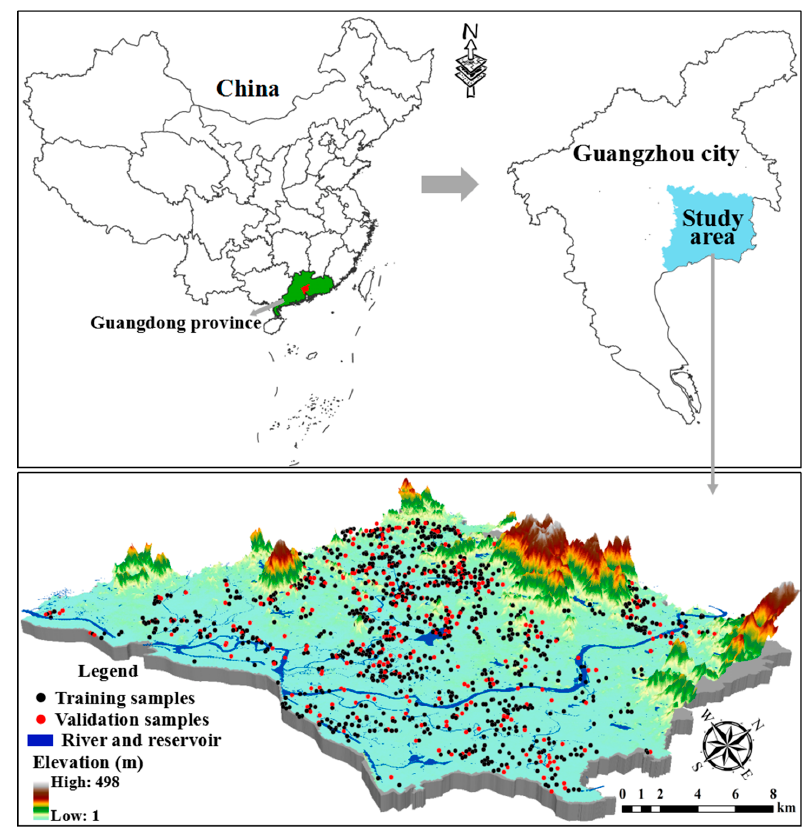
Figure 1. Location of study area in the northeast of Pearl River Delta (PRD) and distribution of the training and validation sites.